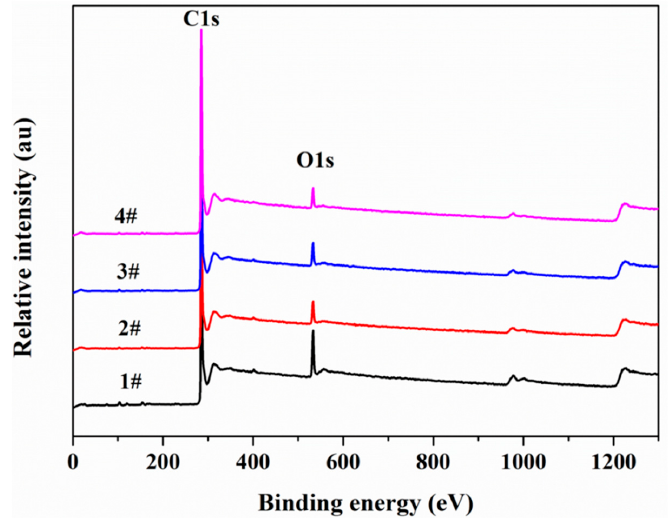
Figure 8. XPS spectra of each carbonaceous deposit layer in the coking chamber. Table 3. XPS test data of each carbonaceous deposit layer in the coking chamber.